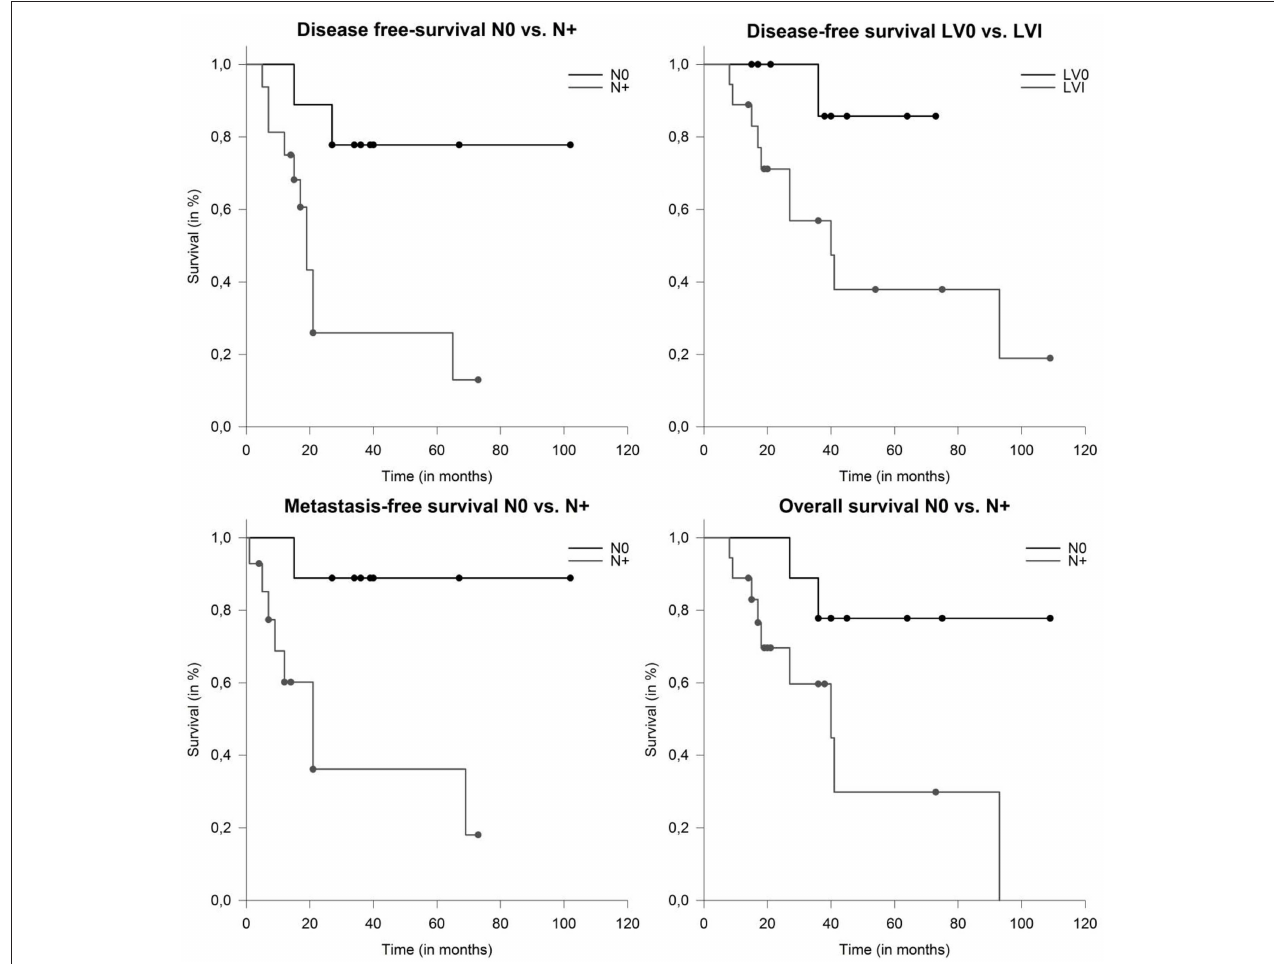
FIGURE 4 | Median disease-free survival (DFS) depending on nodal involvement ( p = 0.009) and lymphovascular involvement ( p = 0.045). Metastasis-free survival and overall survival (OS) in patients with salivary duct carcinoma (SDC) depending on nodal involvement ( p = 0.02 and p =